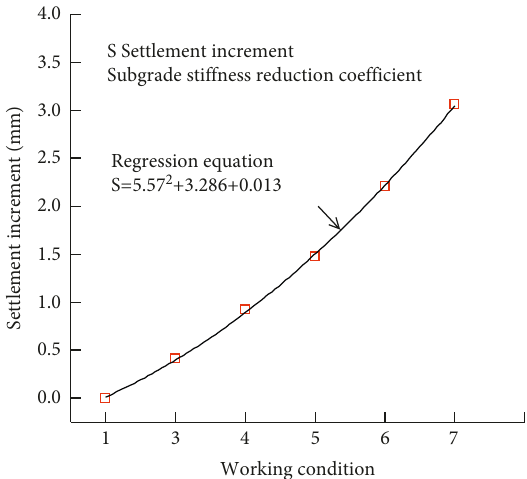
Figure 14: The displacement of joint 1 under different working conditions.